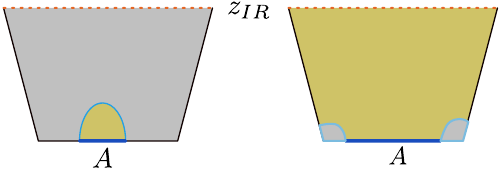
Fig. 22 Illustration of the entanglement and complexity phase transi- tion in a system with two boundaries, as a function of the size of the boundary region A . The region inside the RT surface is colored in yel- low. Note that in the right figure this region extends to the IR cutoff and an IR regulator is needed to give a finite result. This effect is due to working within the Poincaré patch and is not present when considering global